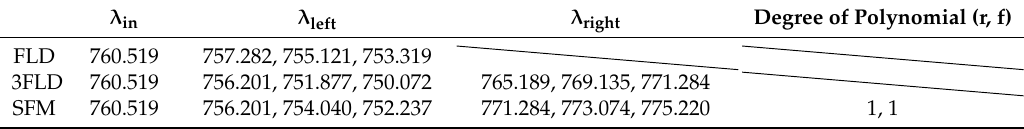
Table 3. Different parameters set of each fluorescence extraction algorithm for the O 2 -A absorption band. λ in λ left λ right Degree of Polynomial (r, f)